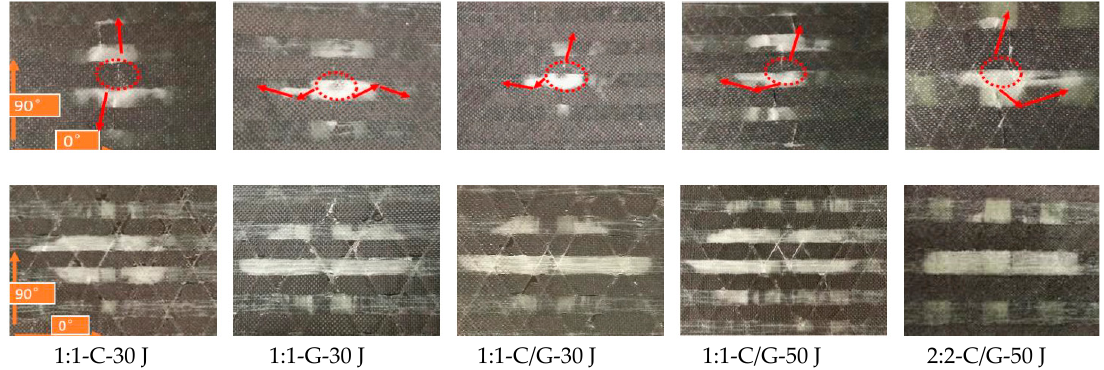
Figure 8. Front and back view photographs of intralayer hybrid composite specimens after impact. Row 1: front, Row 2: back.